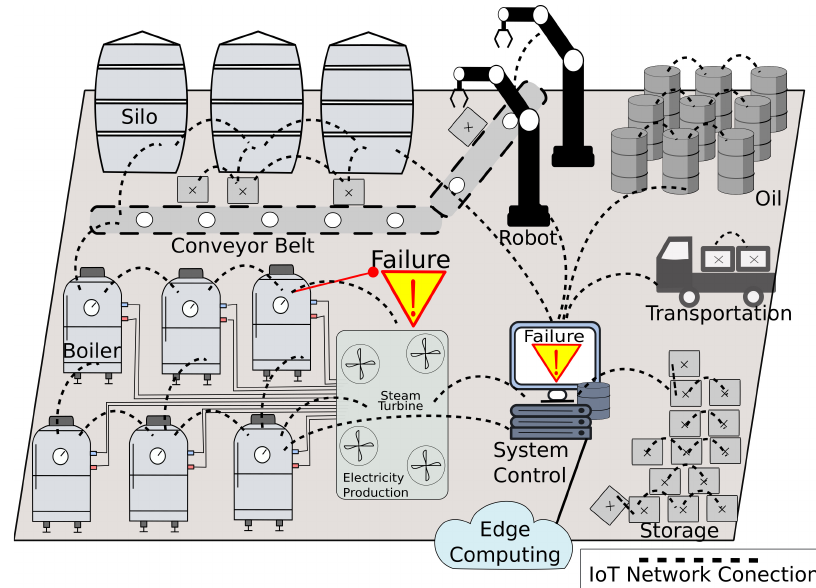
Figure 1. Industry scenario.